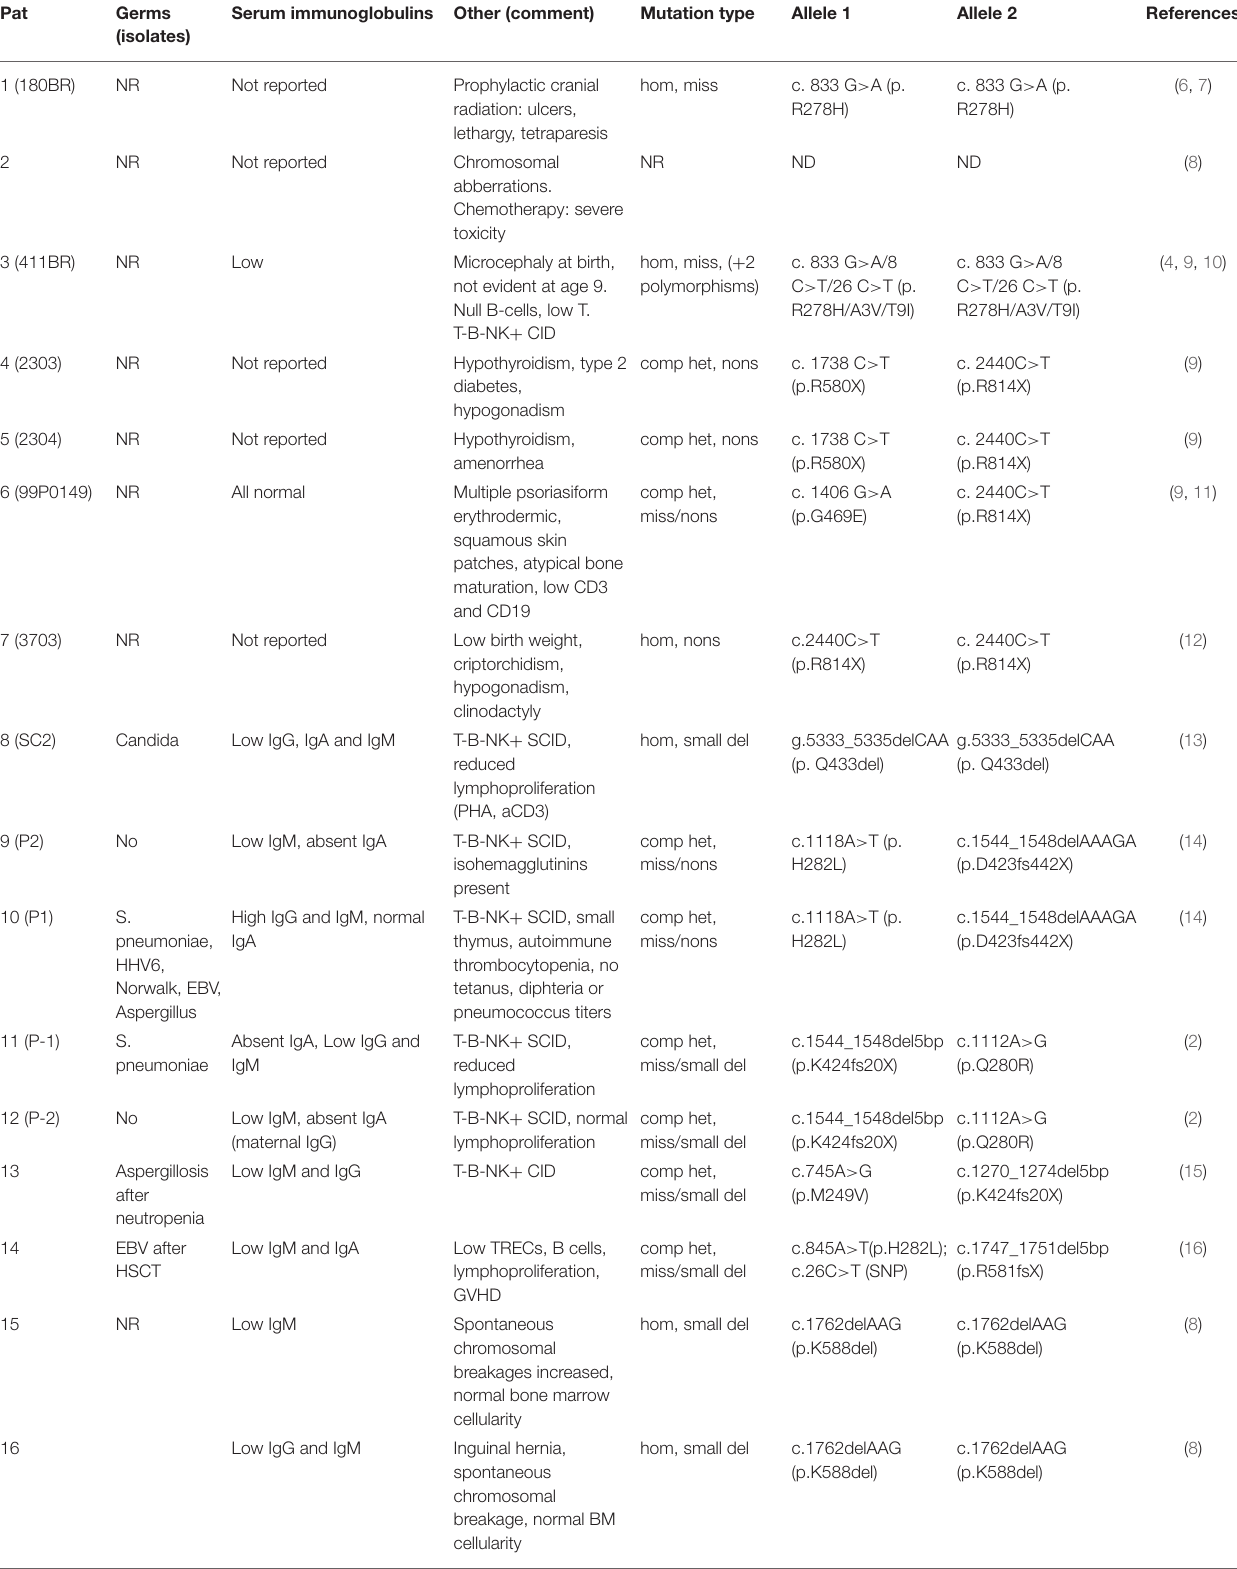
TABLE 3 | Immunological and genetic features of published patients with LIG4 deficiency. Pat Germs Serum immunoglobulins Other (comment) Mutation type Allele 1 Allele (isolates)